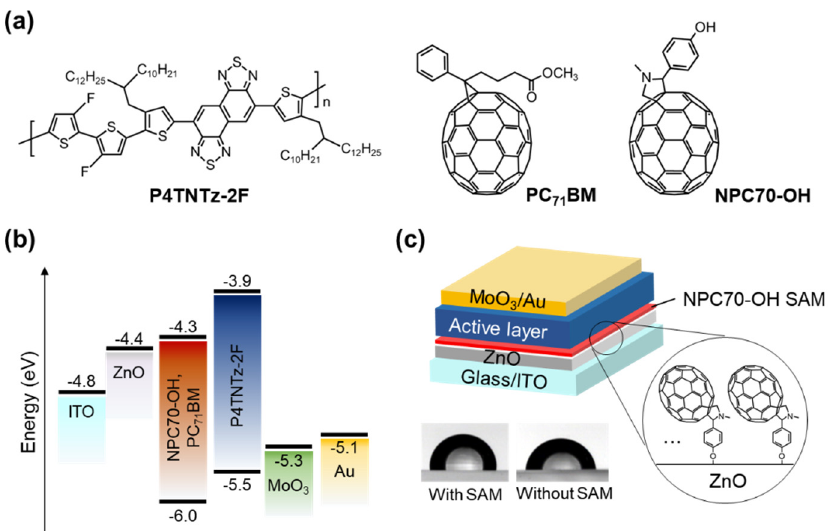
Figure 1. Materials and device structure used in this study. ( a ) Chemical structures of materials. ( b ) Energy level diagram of materials used for device fabrication. ( c ) Device structure of solar cell with fullerene-SAM treatment on ZnO surface. Inset: Water contact angle measurements on ZnO surface with and without fullerene-SAM.